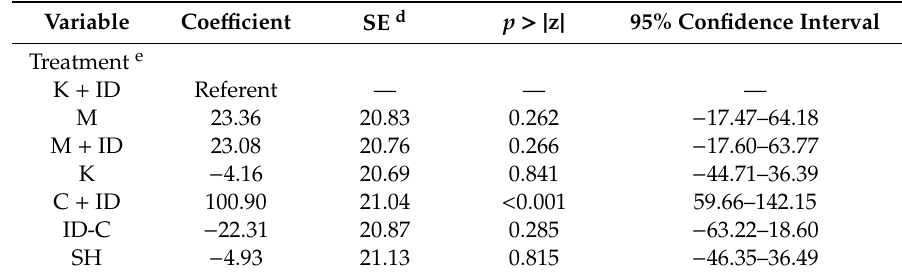
Table 5. Serum cortisol (nmol / L) 1-h post-castration by treatment group using ketoprofen and iron dextran (K + ID) treatment group as the referent category, accounting for additional fixed a and random b e ff ects (model 3) c